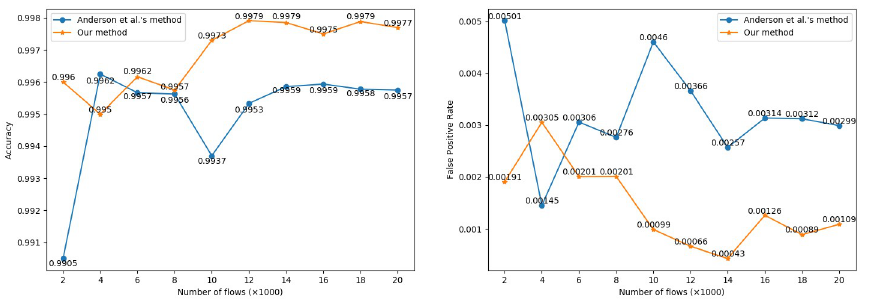
Fig 5. Comparison of the two